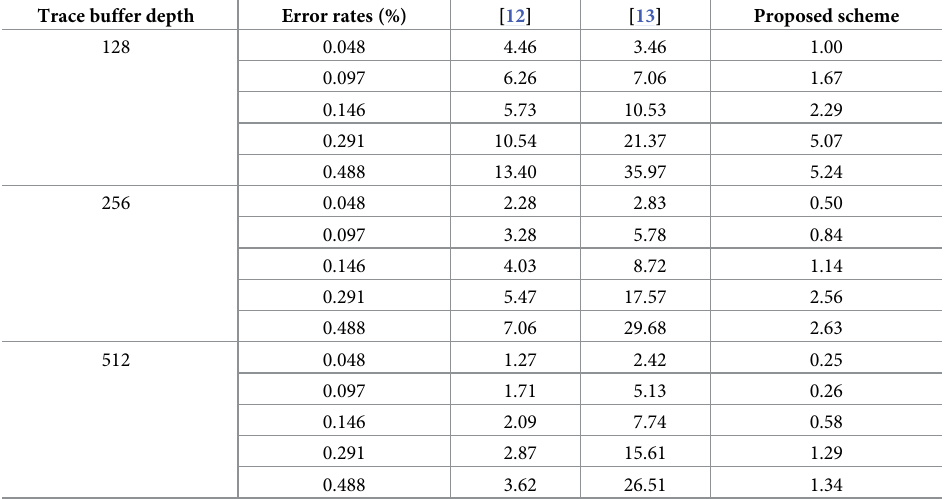
Table 1. The required average number of error-suspect debug cycles for error identification